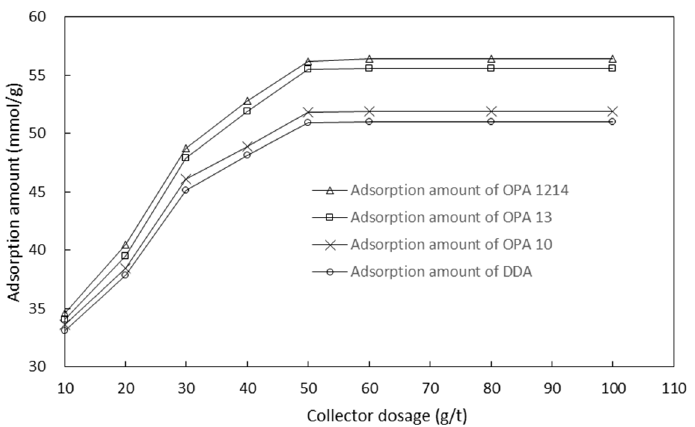
Figure 7. Adsorption amount of each collector on smithsonite particles at different collector concen ‐ trations.